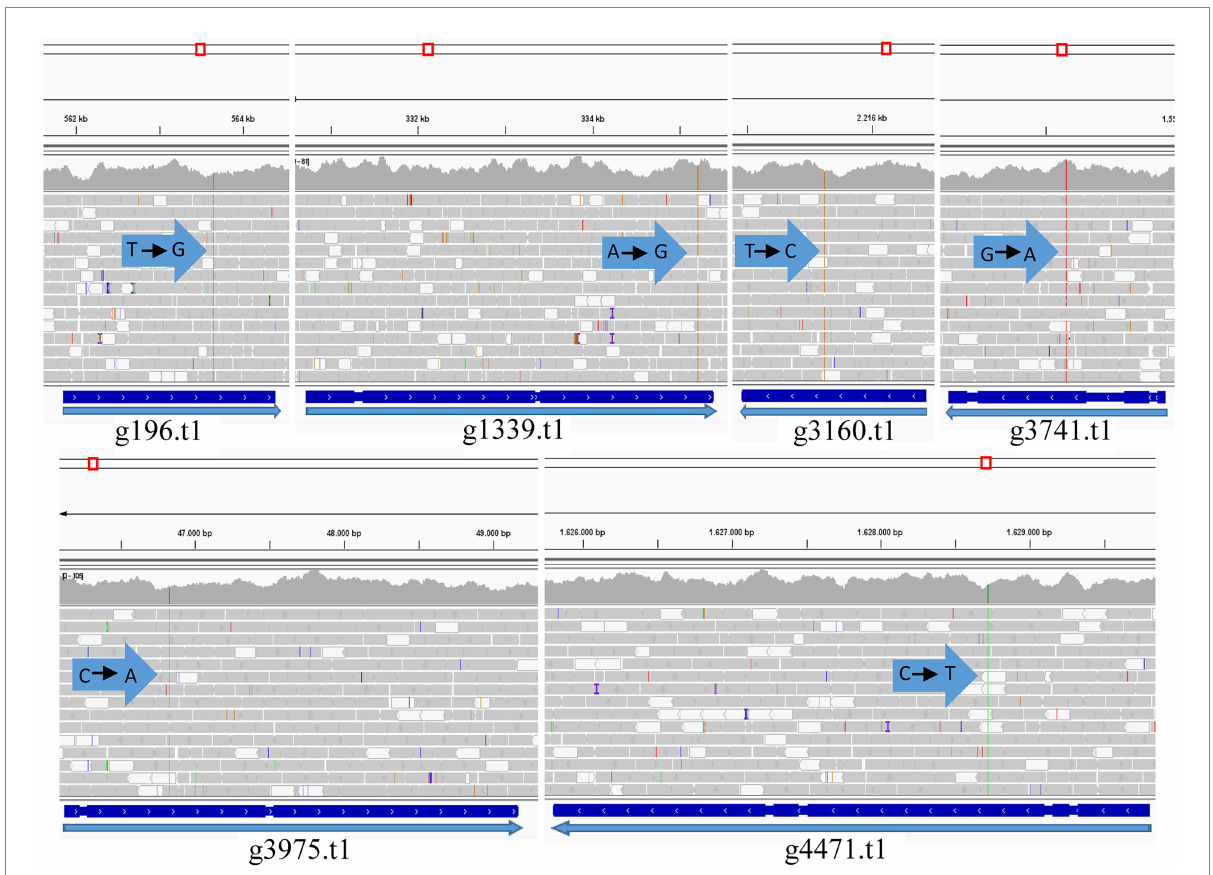
FIGURE 7 Graph mapping the S27 reads against the PO212 reference genome in the genes containing the variation (PO212 genes): g196.t1 (Dimethylglycine oxidase), g1339.t1 (Vegetative incompatibility protein HET-E-1), g3160.t1 (Putative mitochondrial chaperone), g3741.t1 (Hypothetical protein), g3975.t1 (RNA polymerase I specific TF), and g4471.t1 (Hypothetical protein). Arrows indicate the point of variation and nucleotide change (Visualized with